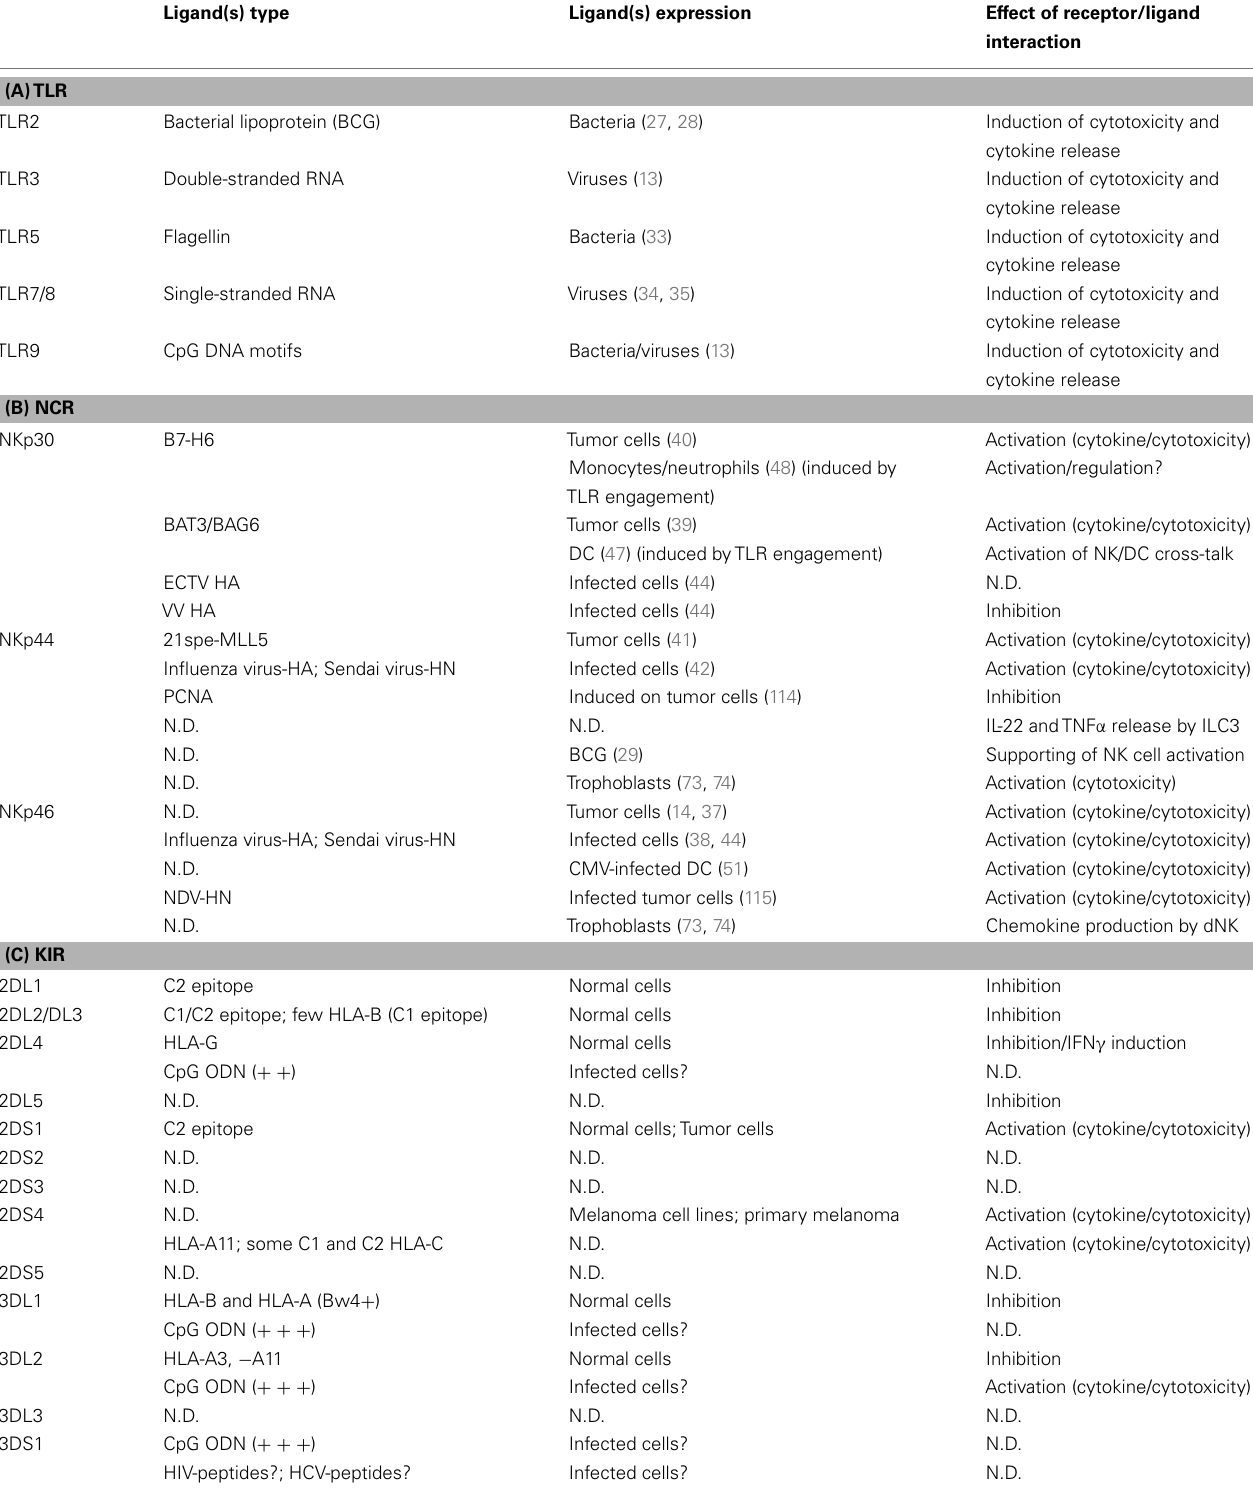
Table 1 | (A)TLRs expressed by human NK cells and relative ligands: effect of their interaction; (B) NCRs expressed by human NK cells and relative ligands: effect of their interaction; (C) KIRs expressed by human NK cells and relative ligands: effect of their